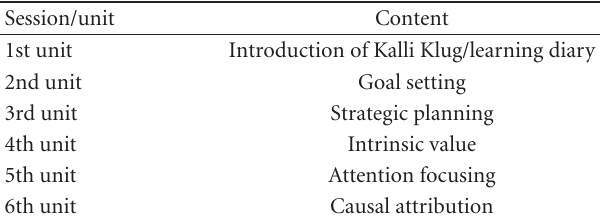
Table 1: Overview of the contents of the di ff erent